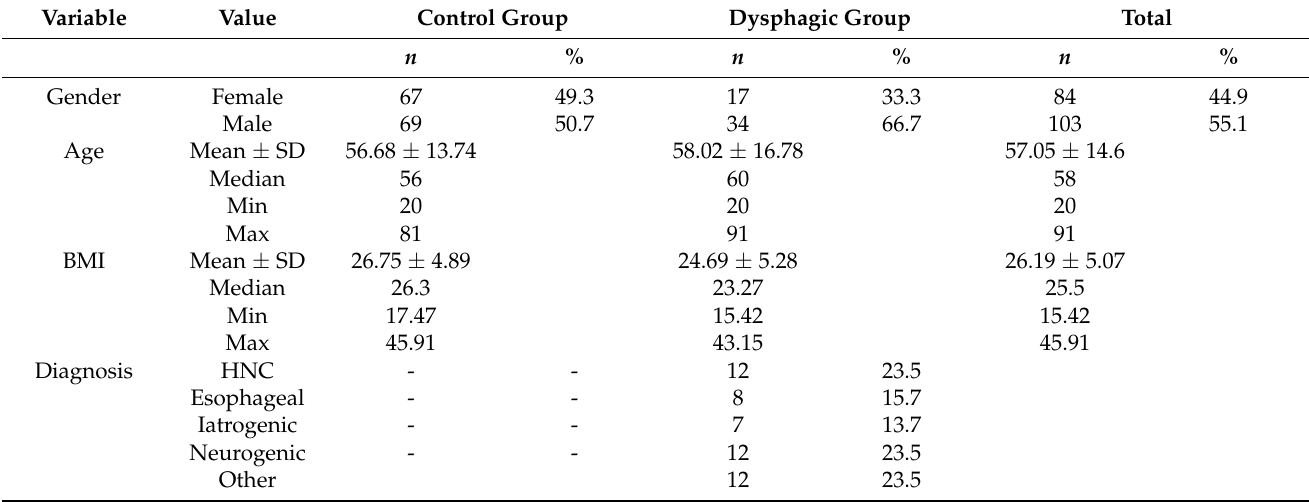
Table 2. The demographic and clinical characteristics of the